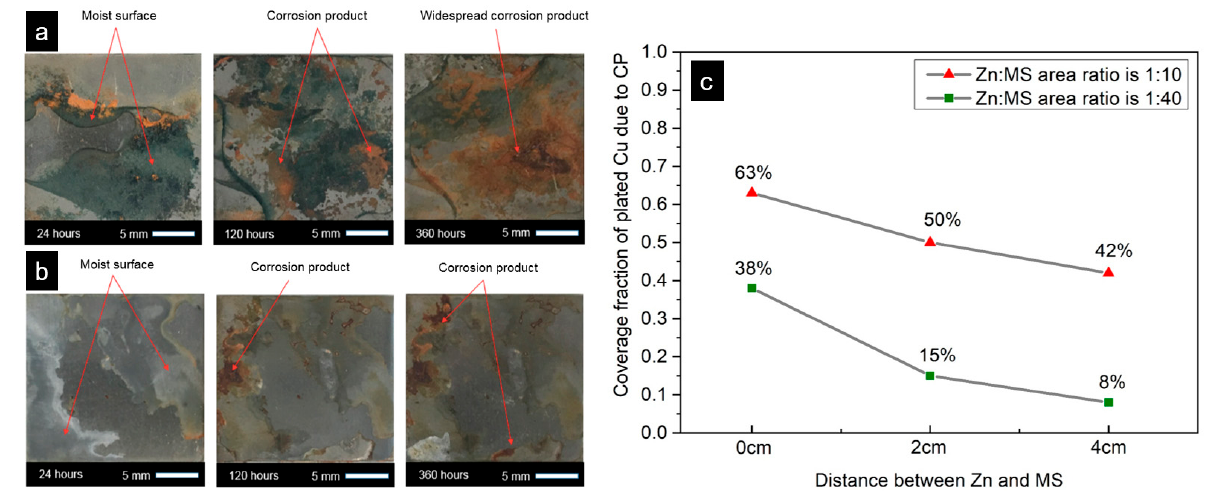
Figure 15. CUI mitigation using cathodic protection, ( a , b ) a proof-of-concept that cathodic protection using sacrificial Zn can mitigate CUI on mild steel, in which ( a ) represents mild steel surface morphologies in the absence of Zn protection, ( b ) represents mild steel surface morphologies with Zn protection and ( c ) represents the achievable cathodic protection area (represented by the Cu plated region) on steel test plates under different Zn to MS contact modes (0 cm, 2 cm, and 4 cm contact distances) and different Zn to MS area ratios (1:10 and 1:40). Samples and data were analysed by Cao et al. [121].